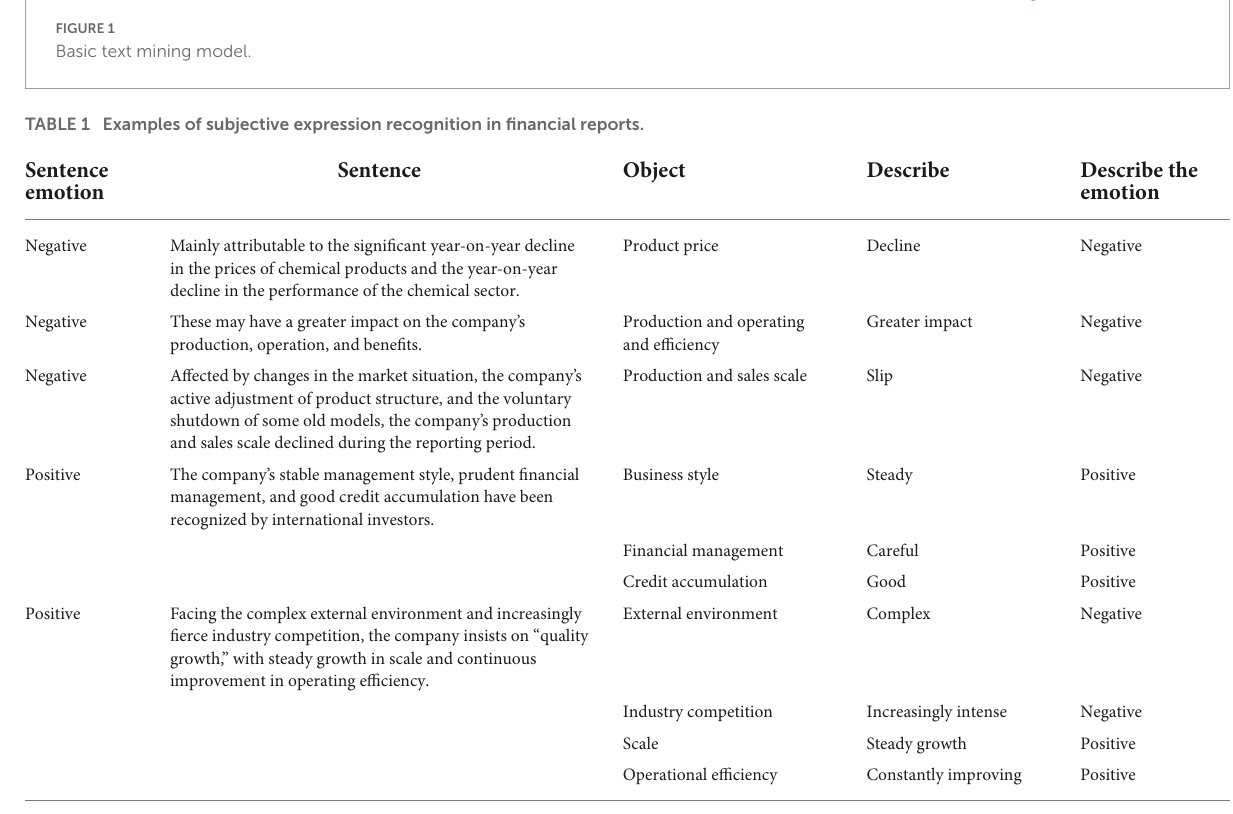
FIGURE1 Basic text mining model.